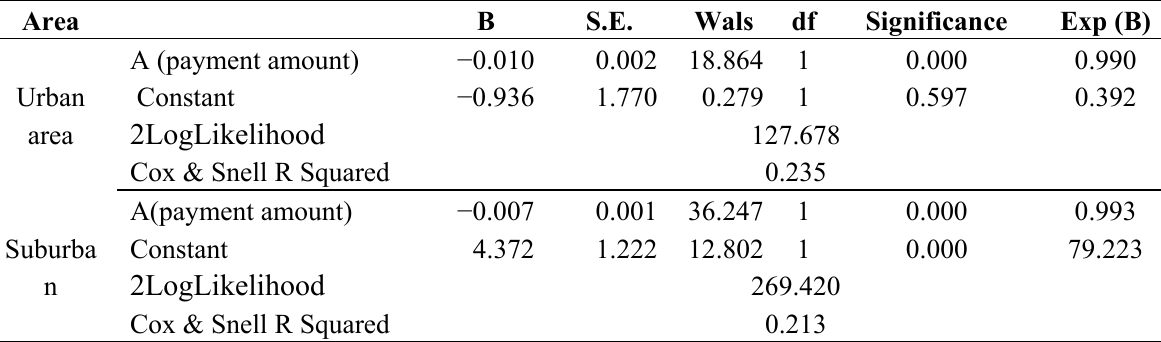
Table 5. Regional difference between urban and suburban